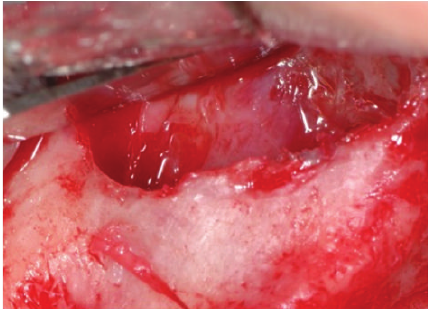
Figure 4: Sinus lift was performed in order to increase the volume of the bone height.